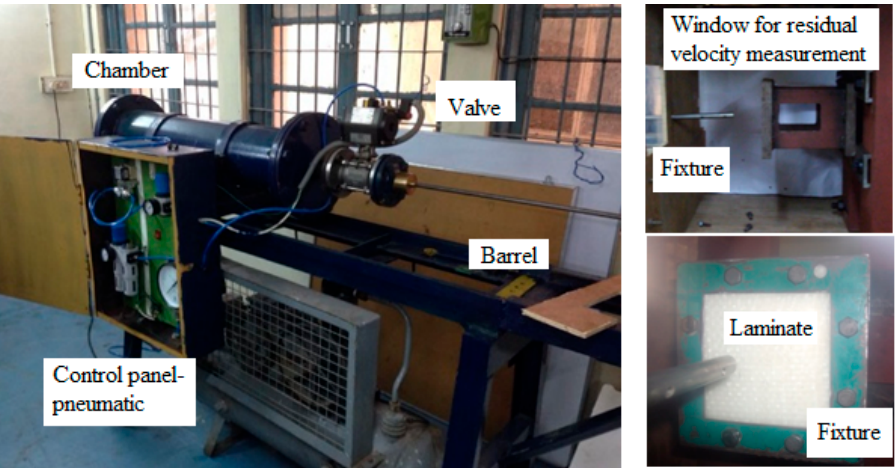
Figure 3. Gas gun experimental set-up used for impact testing on the composite laminates.